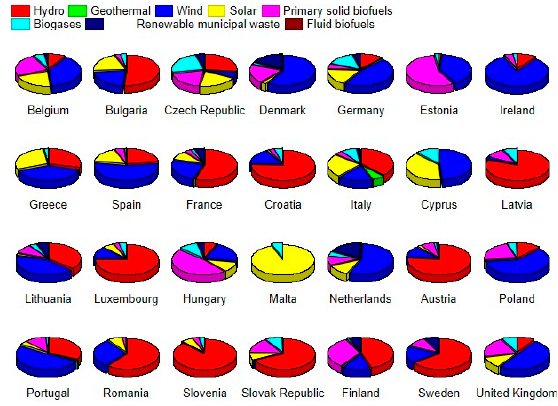
Figure 7. Structure of energy production from renewable energy sources per capita of individual EU countries in 2017 (own study based on data from [37]).